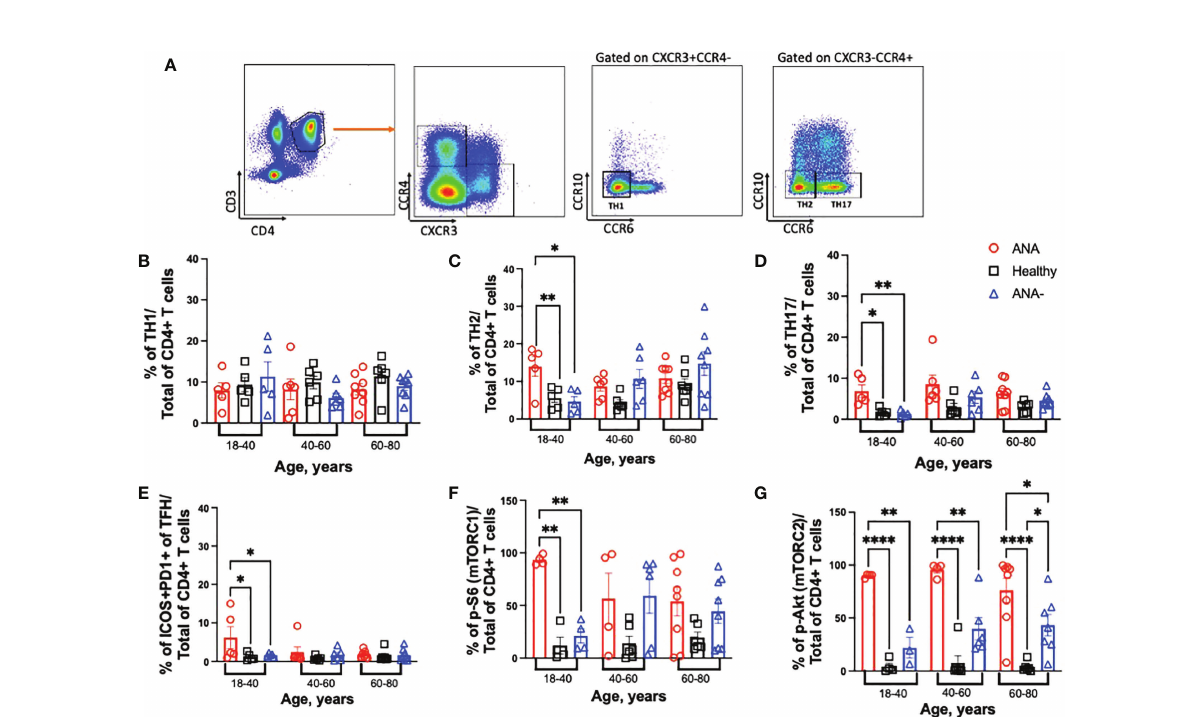
FIGURE 3 Young ANA-positive patients have increased frequencies of TH2 and TH17 CD4+ T cells that are metabolically active. PBMCs were isolated from whole blood collected from ANA-positive patients, ANA-negative patients, and healthy blood donors. Cells were stained with antibodies to identify CD4+ T helper (TH) subsets, activated TFH, and mTOR activation. (A) Representative gating strategy to visualize TH1, TH2 and TH17 CD4+ T cells. The frequencies of (B) TH1, (C) TH2, (D) TH17 and (E) ICOS+PD1+ TFH CD4+ T cells of total CD4+ T cells was determined. mTOR activation was evaluated by (F) p-S6 (marker for mTORC1) and (G) p-Akt (marker for mTORC2) on total CD4+ T cells. Each data point re fl ects one subject (ANA-positive = 20, ANA-negative = 20, healthy blood donors = 32). Data are shown as mean ± SEM and analyzed by one-way ANOVA test followed by Sidak ’ s